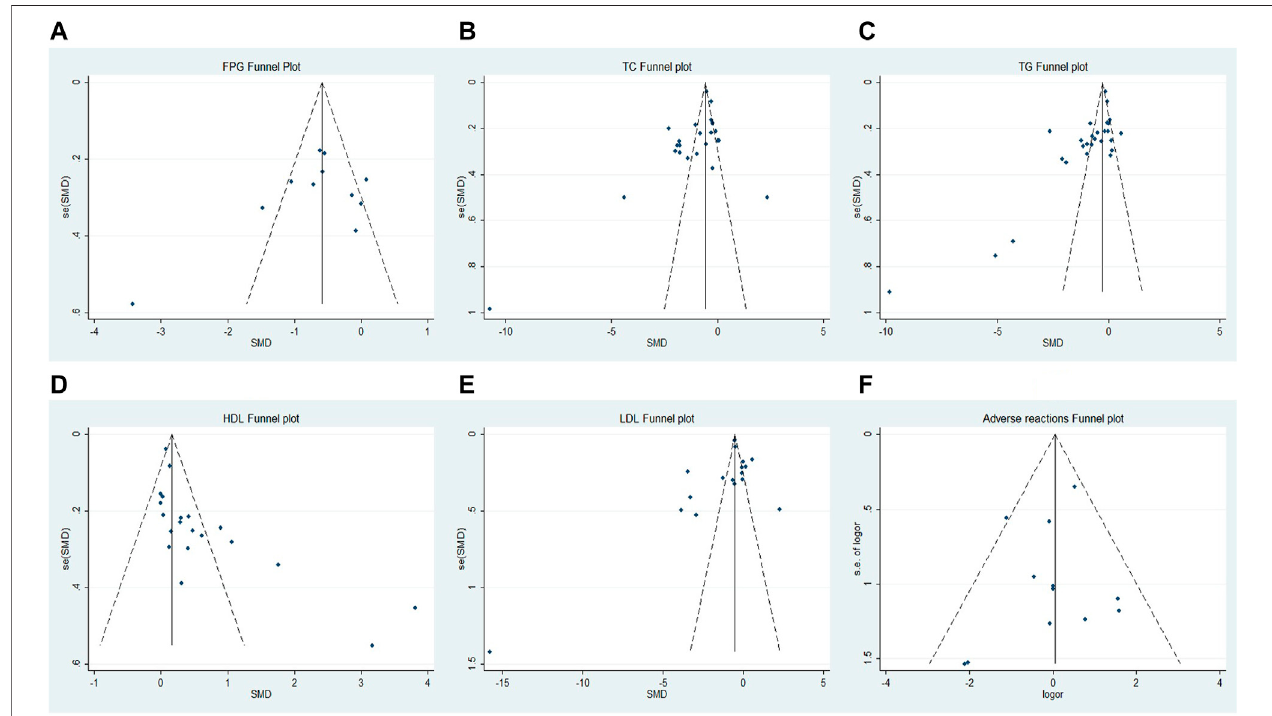
FIGURE 7 | Funnel plots of (A) FPG, (B) TC, (C) TG, (D) HDL − C, (E) LDL − C, and (F) adverse reactions.